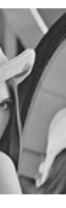
Figure 4. Standard 8-bit grayscale Lena image.